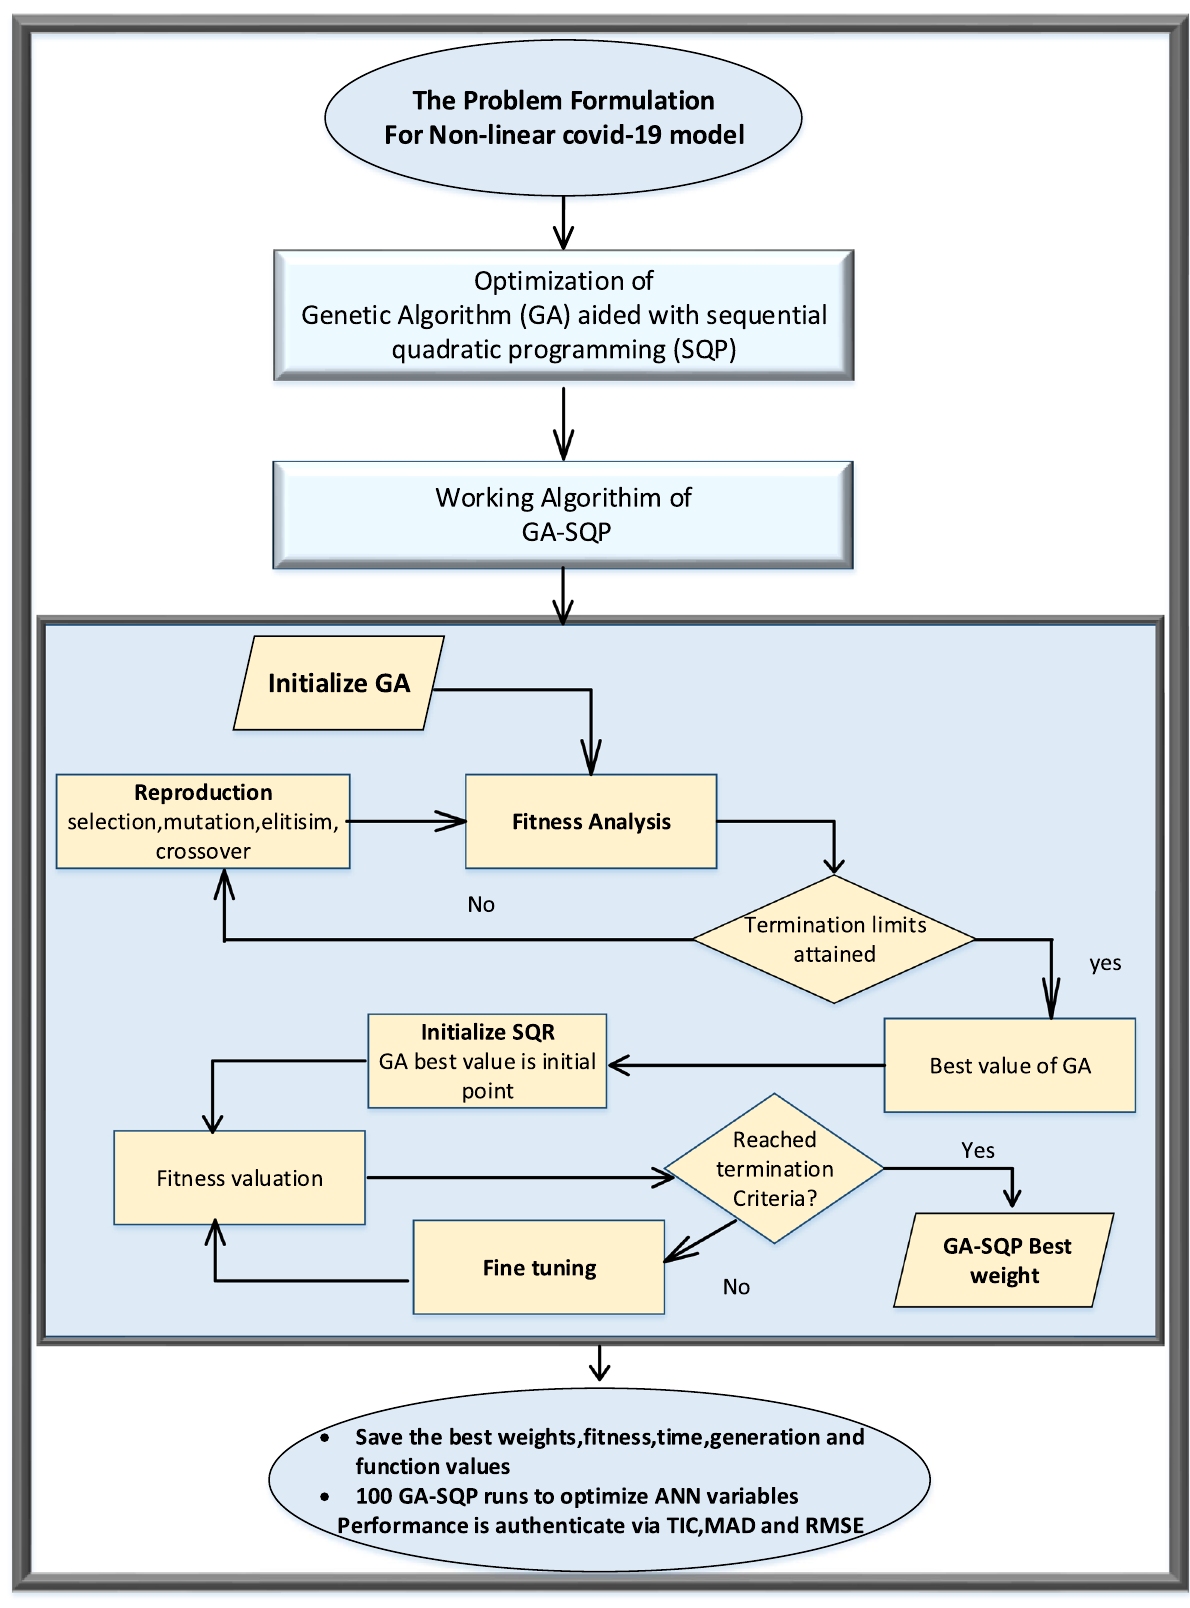
Fig. 1 Designed methodology of COVID-19 SIR